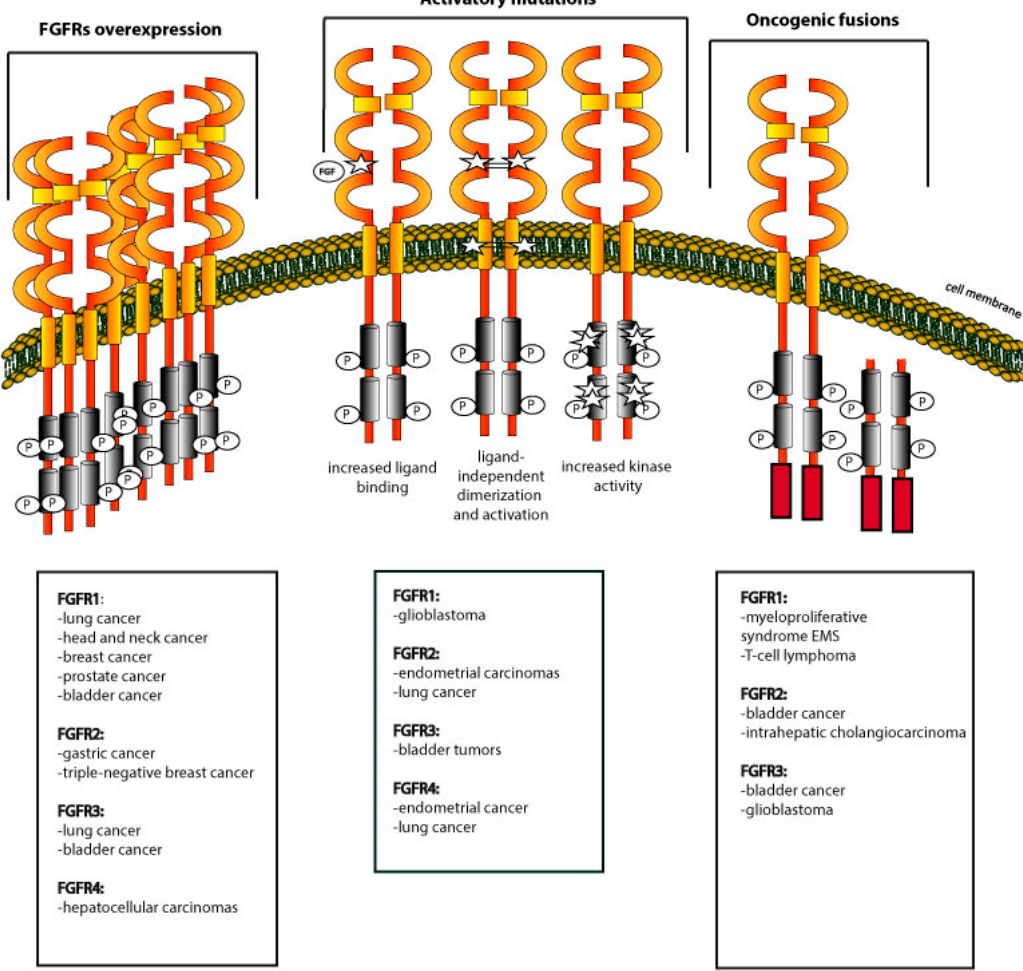
Figure 2. Dysregulation of FGFRs in cancer. FGFRs overexpression, mutations, and fusion proteins are often identified in various tumors, and lead to uncontrolled, oncogenic signaling. The most frequently found FGFRs alternations in particular cancers are indicated below the